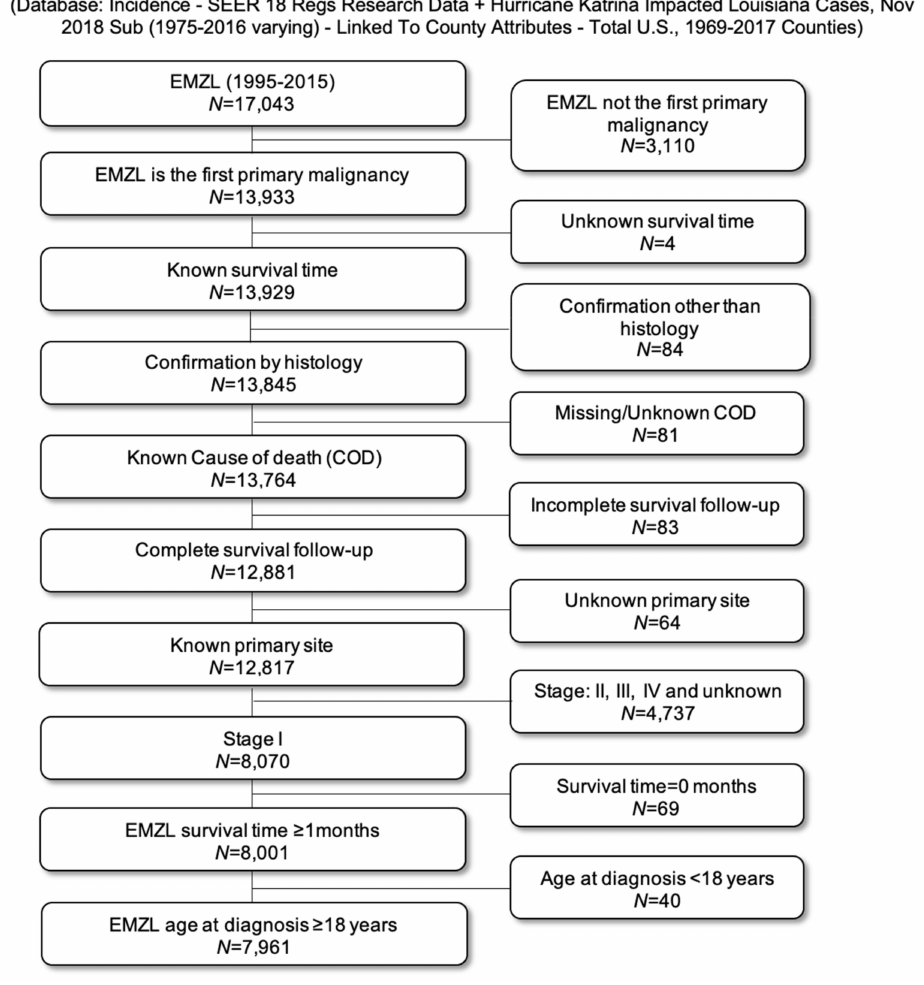
Figure 1. Consort chart of patient